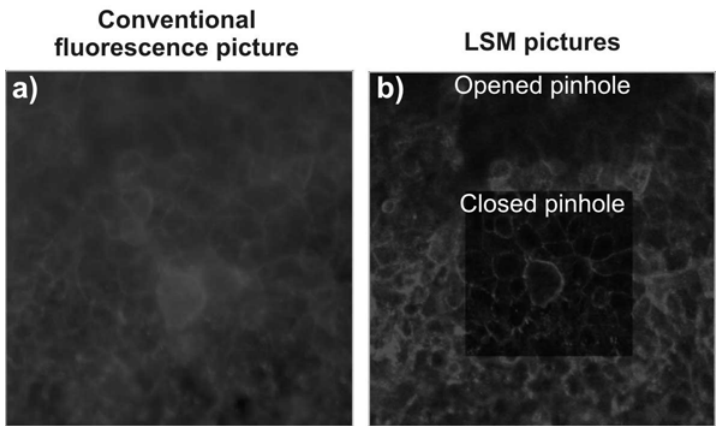
Comparison of conventional fluorescence microscopy and LSM . Epithelial cells (16HBE14o-; kindly provided by Dr. Gruenert, University of California, San Francisco)) were grown to confluence and then fixed and stained for F-Actin (Phalloidin-Rhodamine). a) A micrograph taken with a CCD camera is represented, b) shows two pictures taken with a Zeiss 510 Meta laser scanning microscope using either an opened pinhole or a closed pinhole. All pictures were taken from the same